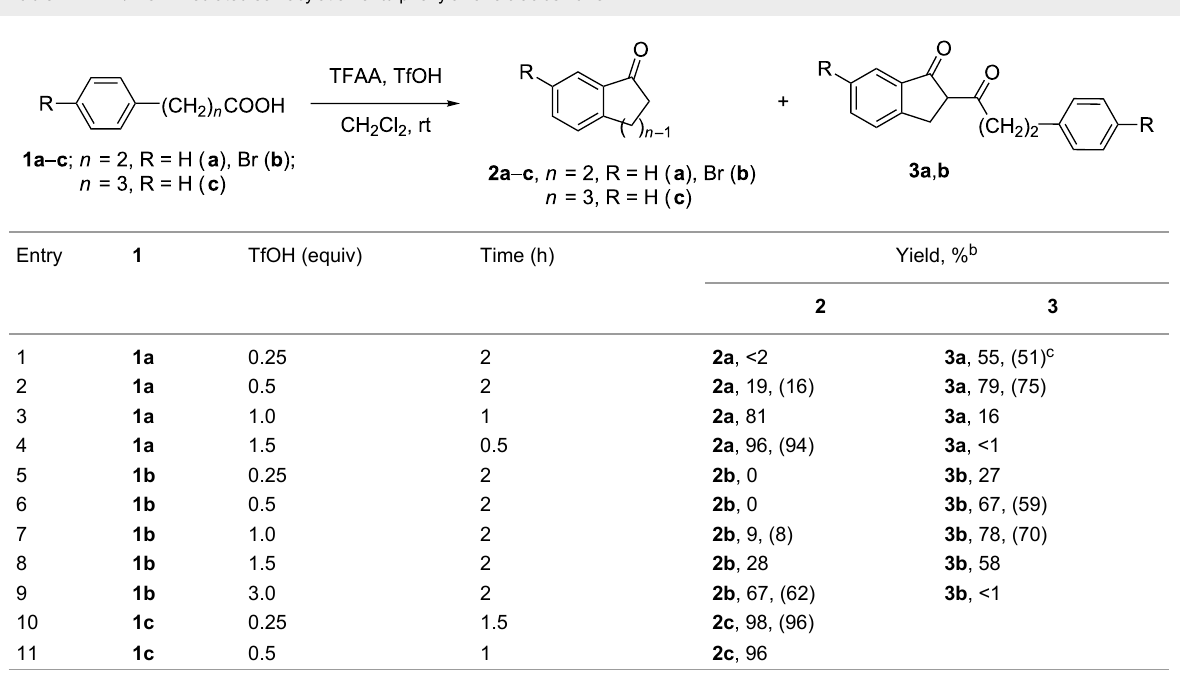
Table 1: TFAA/TfOH-mediated self-acylation of ω -phenylalkanoic acids 1a – c a